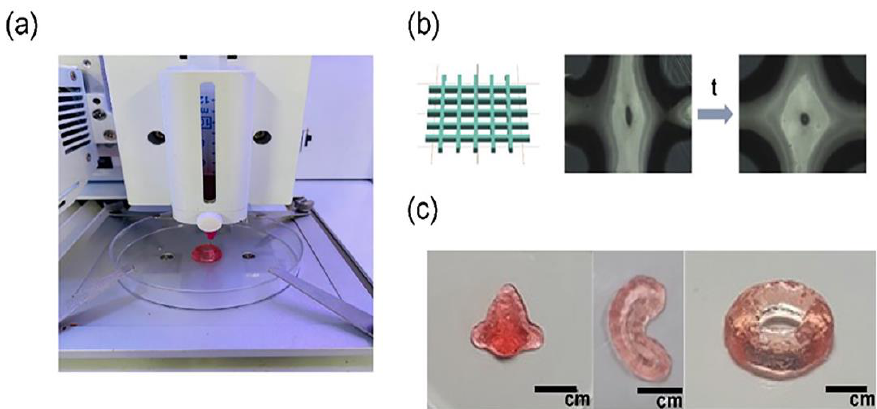
Figure 10. ( a ) Three-dimensional printing of self-healing OHA/GC/ADH/ALG hydrogel encapsulating ATDC5 cells. ( b ) Microscopic images of 3D-printed filaments of OHA/GC/ADH/ALG self-healing hydrogel and ( c ) 3D-printed constructs of various shapes. Reprinted from [27], Copyright 2021, Biomedicines.